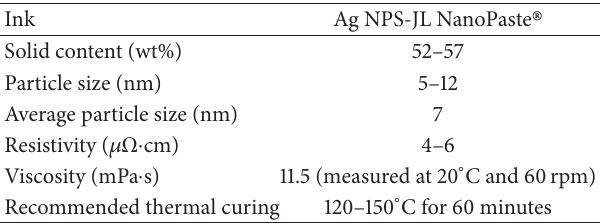
Table 1: Specifications of the utilized ink [10].